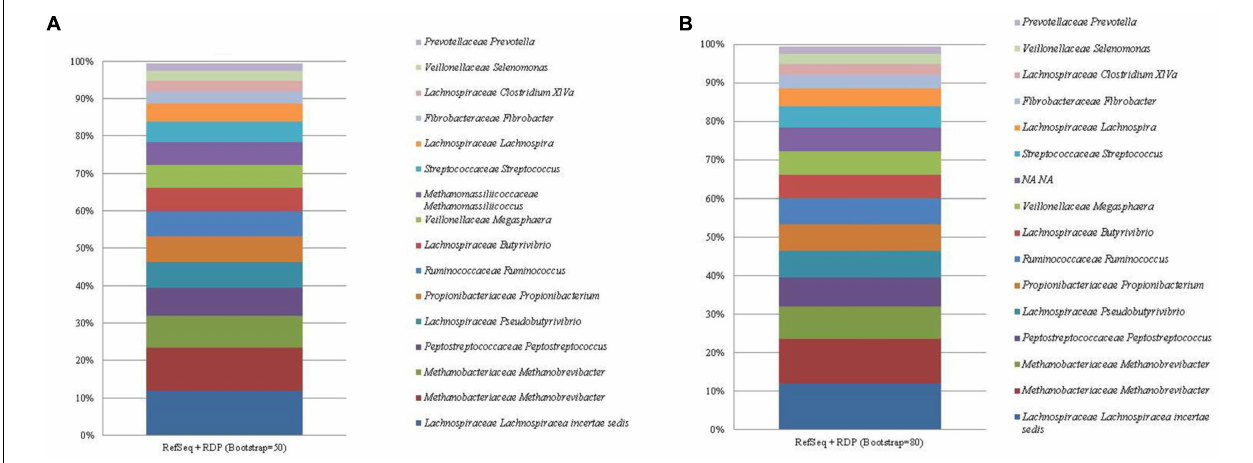
FIGURE 4 | The mean relative abundance and RefSeq + RDP classification (family and genus) of the 16 most abundant sequences in libraries generated from the rumen specific reference standard. Bootstrapping threshold: (A) 50 and (B)